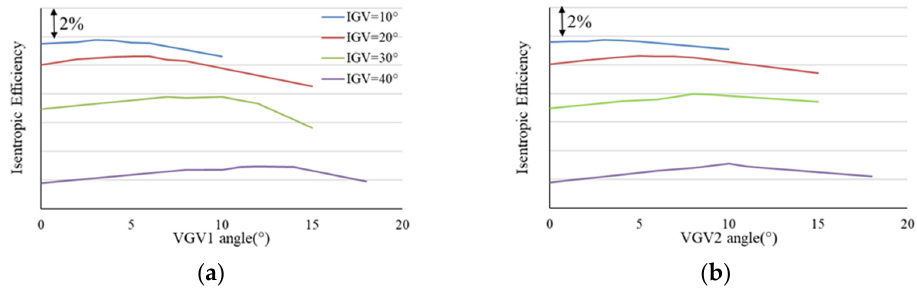
Figure 11. Efficiency varying with VGV turning angle under different IGV opening degrees. ( a ) VGV1; ( b ) VGV2. ( b )